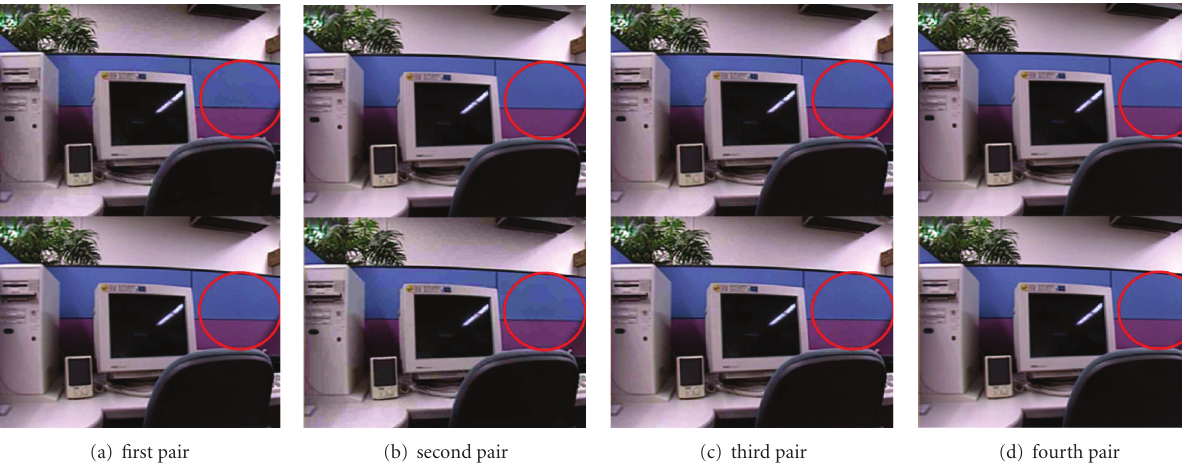
Figure 2: Four monoscopic image pairs with the same “computer” image content: ((a)–(c)) three pairs of distorted images; (d) reference image pairs. The regions marked in red circle can clearly show the di ff erent JPEG compressive qualities of every image.